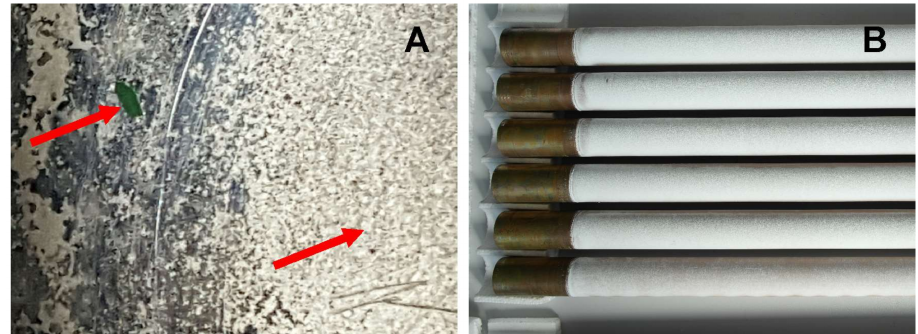
Figure 1. Photographs of the deposits in the domestic water cooker ( A ) and on the tubes of the CuNi alloy tubes from the seawater desalination test rig ( B ). The arrows in panel A indicate the two different types of